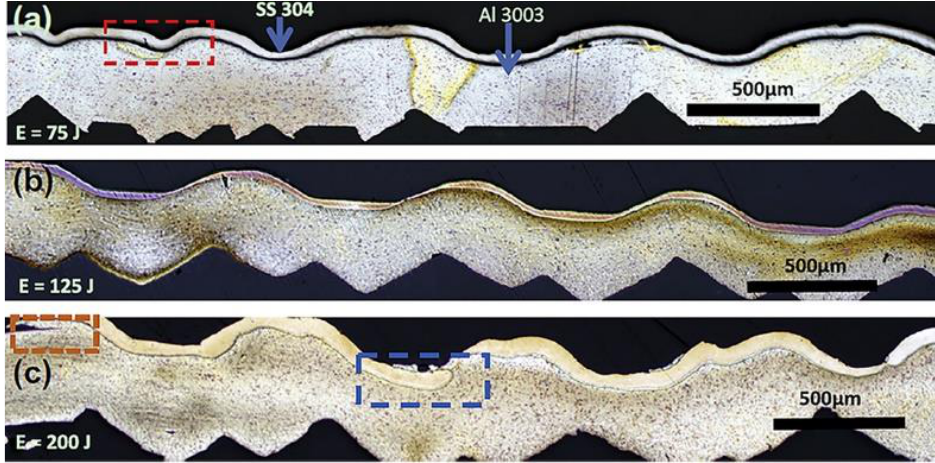
Figure 12. Optical micrographs of weld cross-section with increasing welding energies [40]: ( a ) 75 J; ( b ) 125 J; ( c ) 200 J.